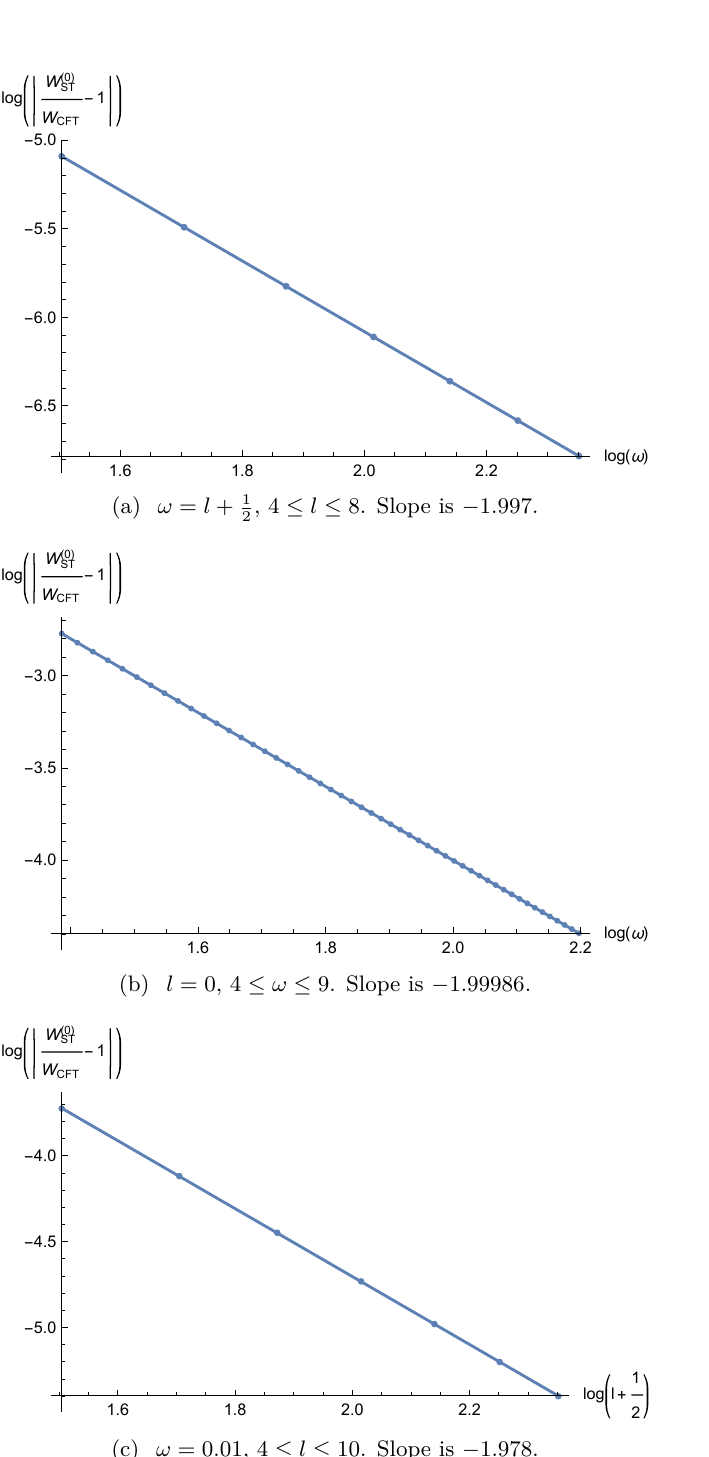
Figure 11 . Numerical log-log plots of the relative discrepancy between the CFT correlator and the spin-0 Sleight-Taronna contributions, at large boundary frequencies ω and/or l . As expected, the discrepancy decays with frequency as ∼ Ω − 2